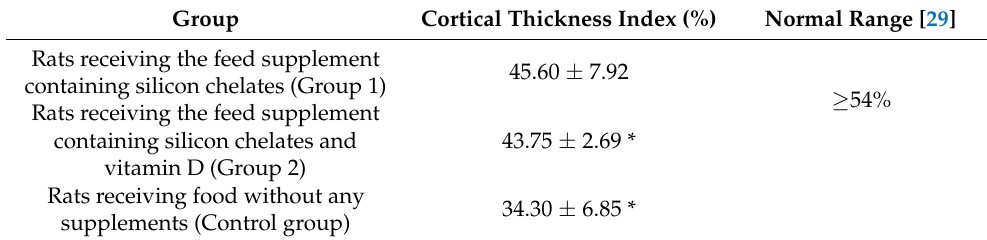
Table 2. The cortical thickness index of rats receiving the feed supplement containing chelated silicon and vitamin D after the experimentally induced mechanical damage to the femoral